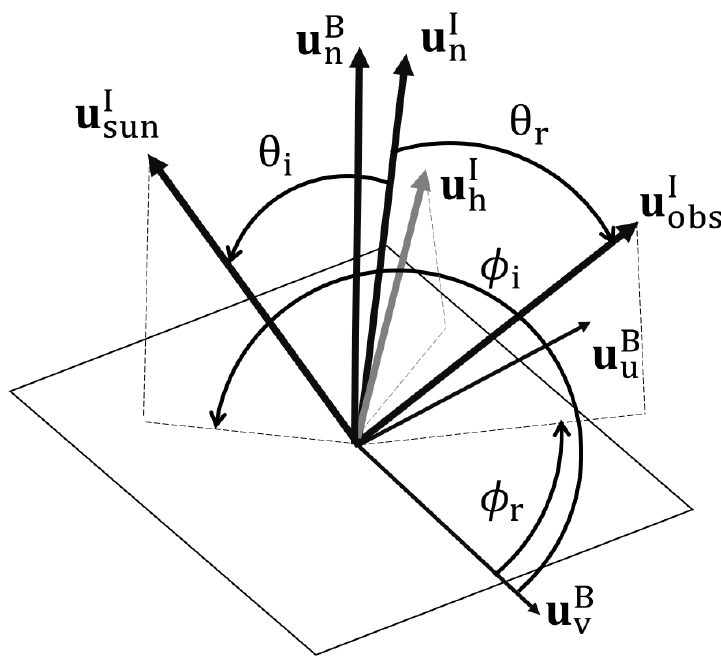
Figure 1. Illumination geometry of a single